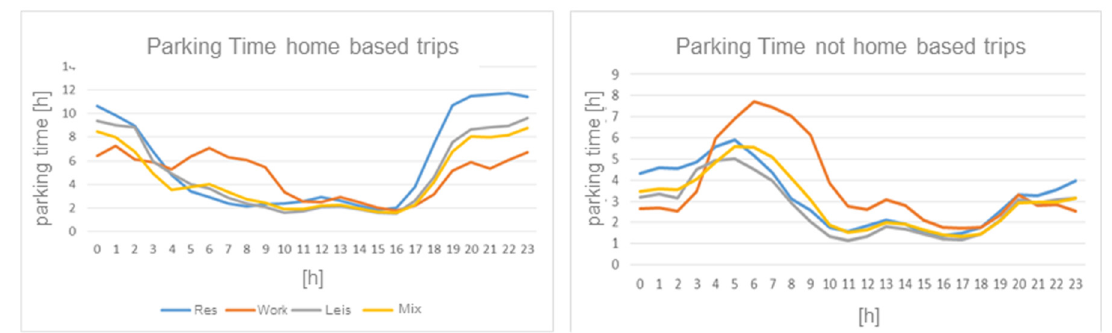
Figure 9. Parking time distribution during the daytime as a function of the land use of the arrival zone for home-based and not-home-based trips.